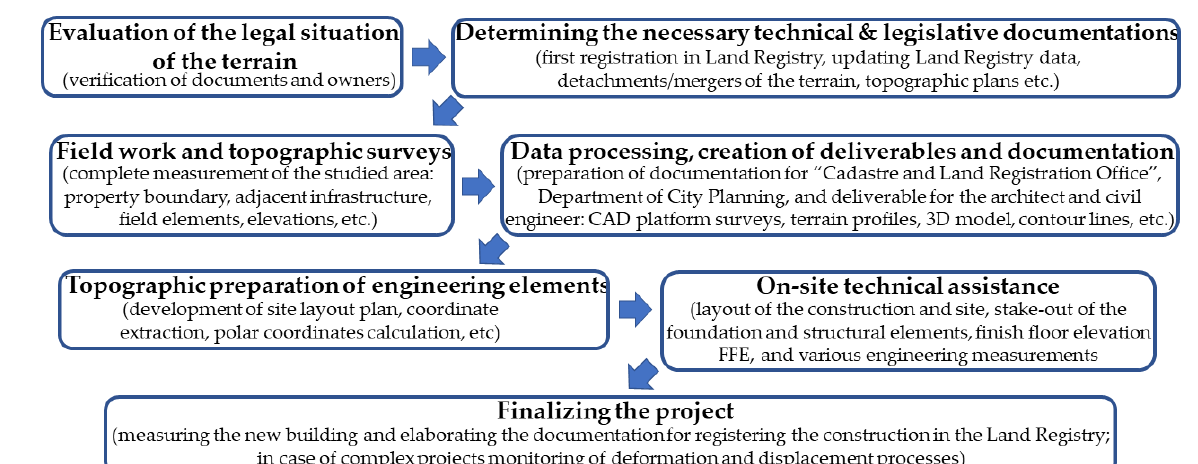
Figure 1. A survey engineer’s typical workflow.